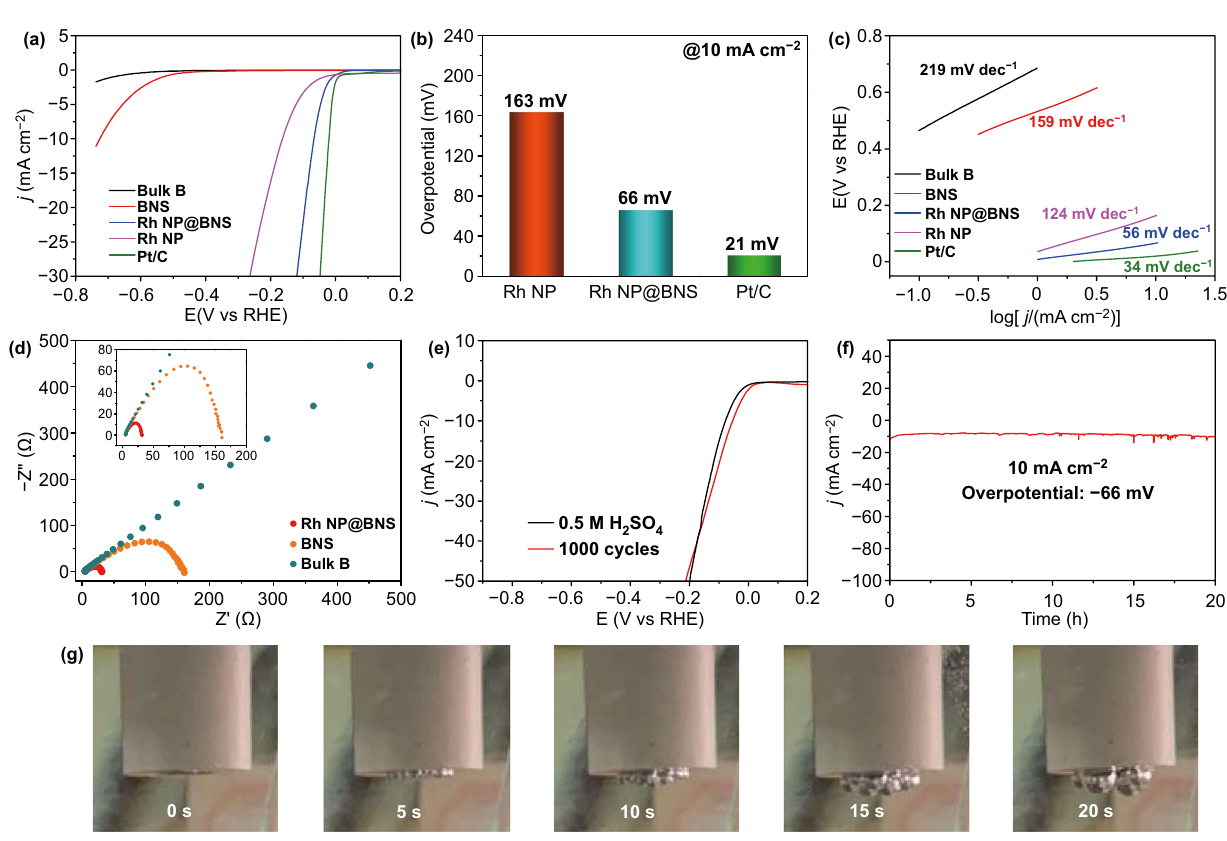
Fig. 3 a LSV curves of bulk B, BNS, Rh NP@BNS, Rh NP, and Pt/C were performed in 0.5 M H 2 SO 4 electrolyte. b Comparison of the overpo- tentials at 10 mA cm −2 . c The corresponding Tafel slopes were derived from LSV curves. d Nyquist plots of bulk B, BNS, and Rh NP@BNS. e LSV curves were measured before and after 1000 cycles at 0.2 to – 0.9 V versus RHE in 0.5 M H 2 SO 4 electrolyte. f Time dependence of current density at 66 mV versus RHE. g Photos of a working electrode using Rh NP@BNS as a catalyst during CV measurement from 0 to − 0.2 V in 0.5 M H 2 SO 4 electrolyte. The photos were taken at 5 s